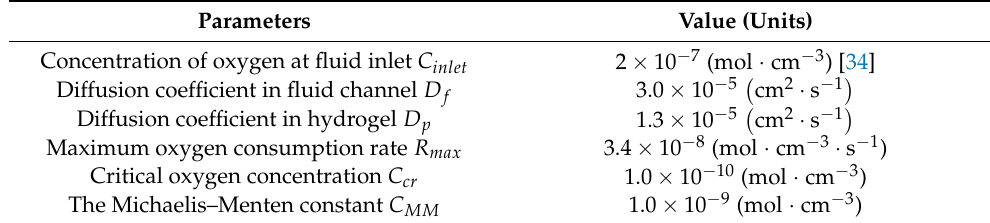
Table 2. Parameters for the coupled convection-reaction-diffusion